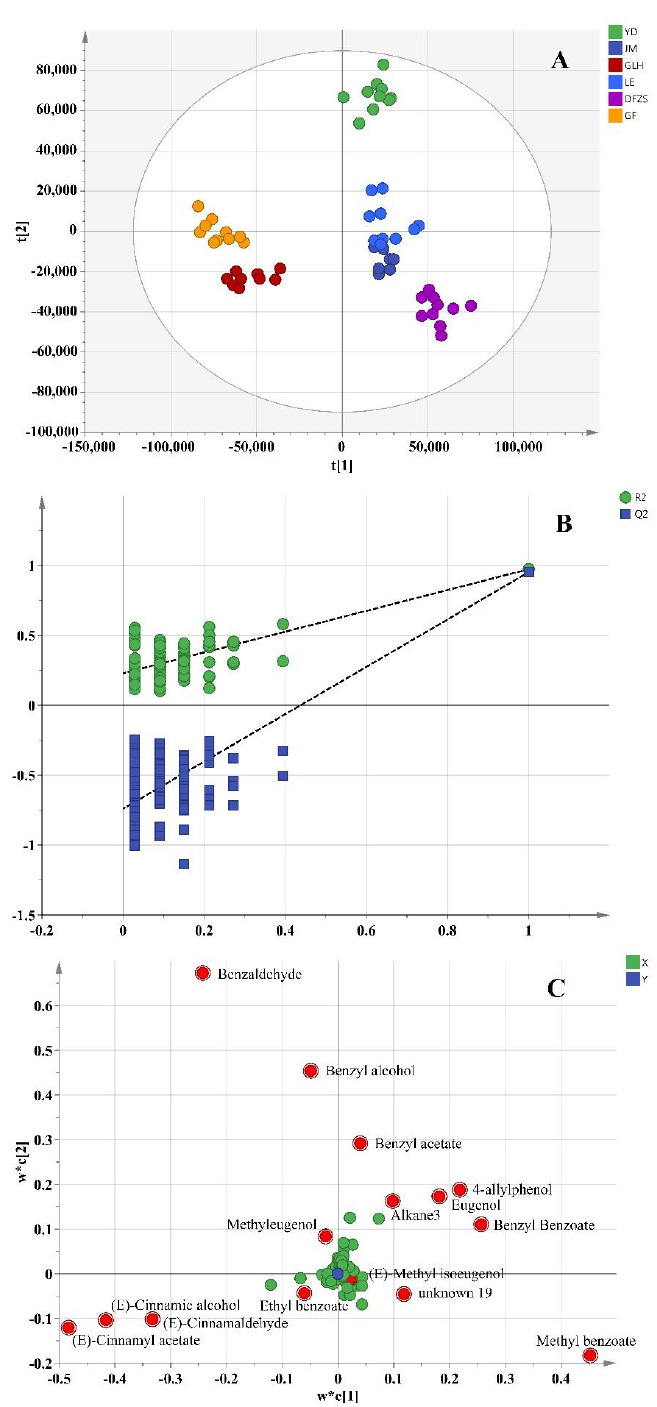
Figure 2. PLS-DA analysis of volatile compounds of six varieties of P. mume blossom samples. ( A ) PLS-DA score plot; ( B ) cross-validation plot of the PLS-DA model with 100 permutation tests; ( C ) loading plot of PLS-DA (red dot represents the most differential compounds, VIP > 1).